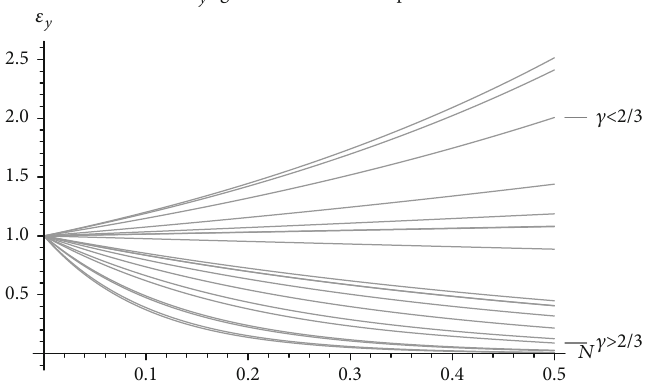
N ) at γ > 2/3 and γ < 2/3 for fi xed point P y